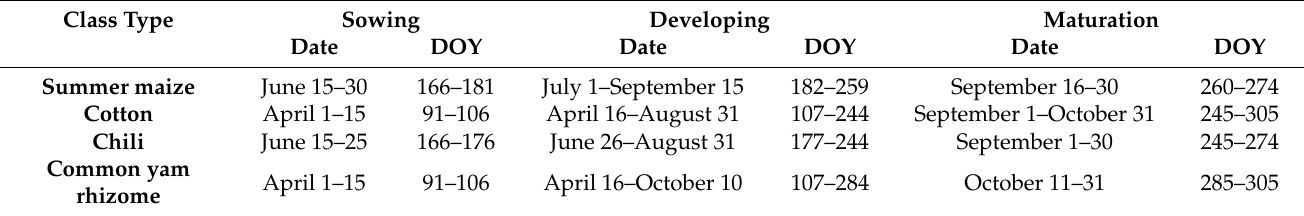
Table 2. Crop calendars of summer maize, cotton, chili, and common yam rhizome in Hengshui, China. DOY, day of year. Class